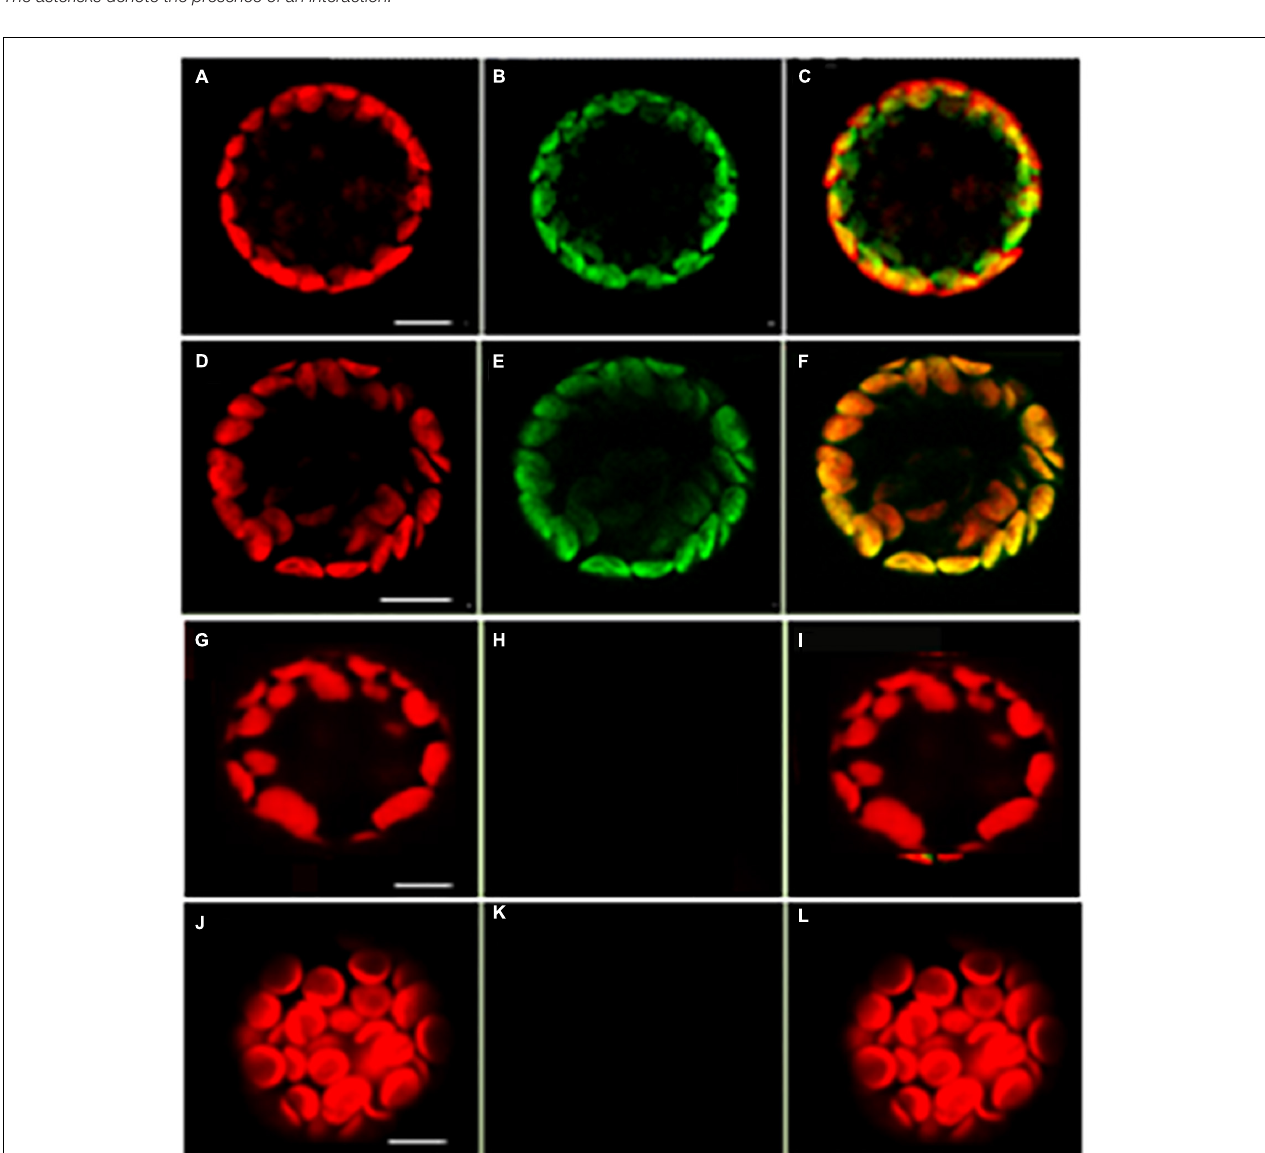
FIGURE 3 | Confocal microscopy images of Arabidopsis mesophyll protoplasts showing interactions between LEA5 and DEA (D/H)-box RNA helicase 22. Protoplasts were co-transfected with LEA5-YFPc and DEA (D/H)-box RNA helicase 22-YFPn (A–C) and LEA5-YFPn with DEA (D/H)-box RNA helicase 22-YFPc (D–F) . Co-transfection of DEA (D/H)-box RNA helicase 22-YFPn and DEA (D/H)-box RNA helicase 22-YFPc gives no positive signal of interaction (G–I) . Overlay of fluorescence signals (C,F,I,L) . The interaction between LEA5-YFPn and LEA5-YFPc in mitochondria is demonstrated by co-transfection of LEA5-YFPn and LEA-YFPc (J–L) . Scale bar = 10 µ